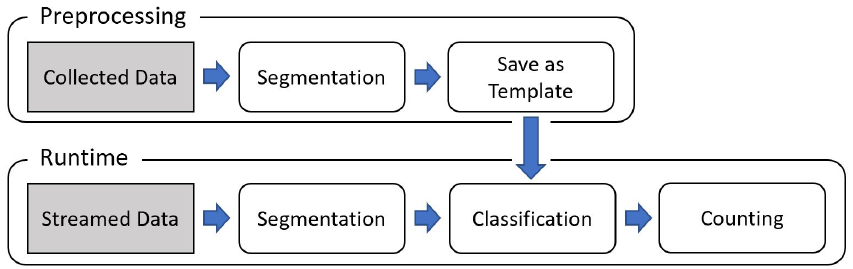
Figure 3. Schematic of the architecture of the proposed